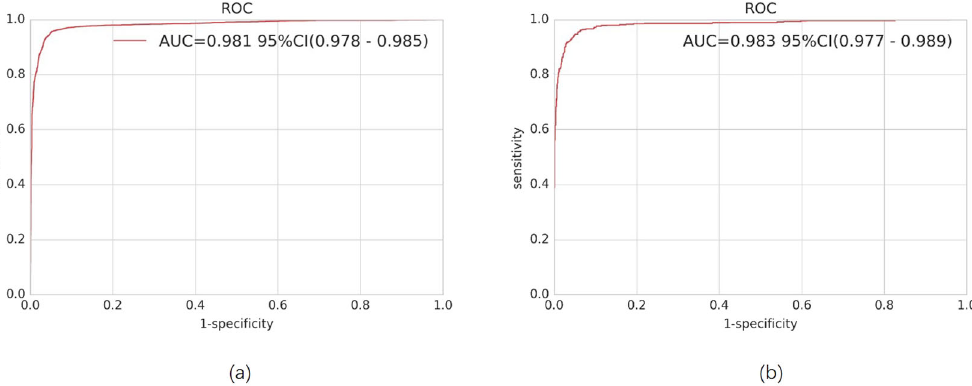
Fig. 3 Graph showing receiver operating characteristic (ROC) curve derived from the validation dataset 1. a and validation dataset 2 ( b ) that was obtained using the hierarchical deep learning system. AUC area under curve.